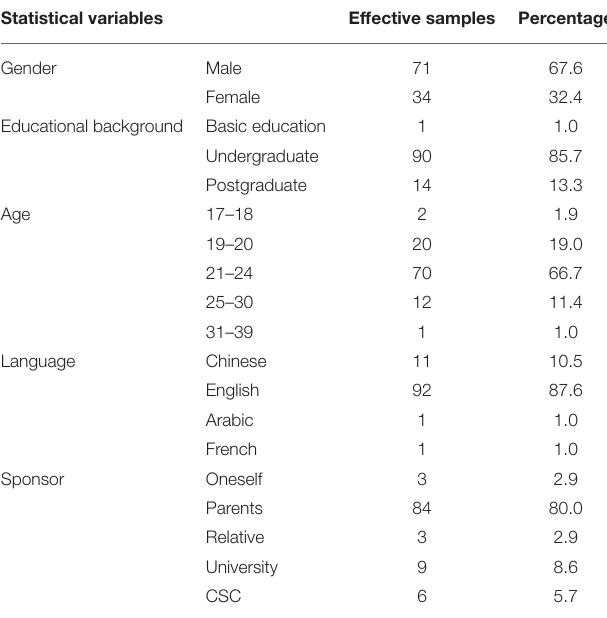
TABLE 1 | Summary of the international students’ sample